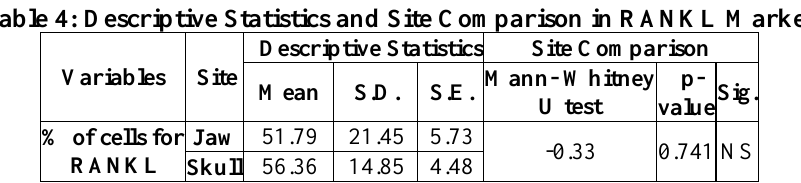
Table 5: Descriptive Statistics and Site Comparison in RANK Marker Variables